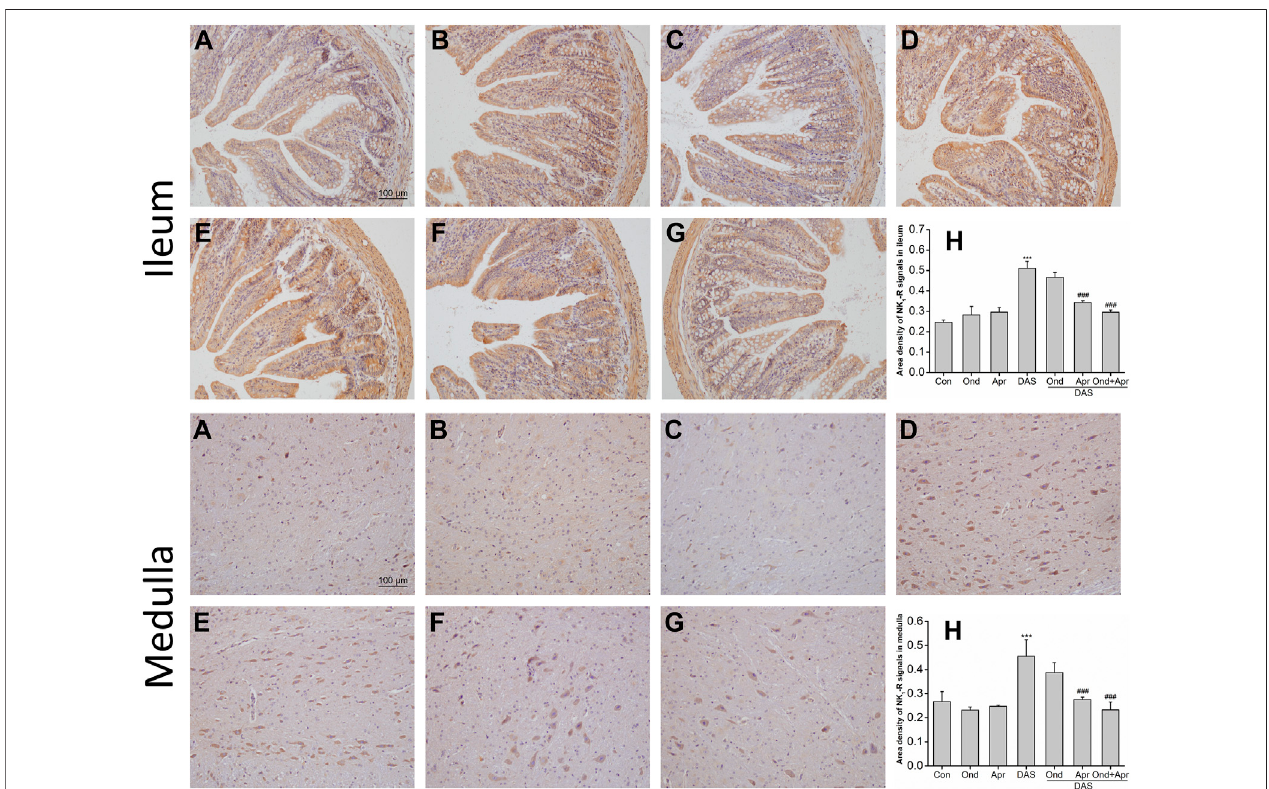
FIGURE10| Theeffect ofOndand Apron DAS-inducedNK 1 receptor expression intheileum and medullaofrats, 4 h after treatment: IHC analysis (A) Control (B) Ond1.66 mg/kg (C) Apr26.2 mg/kg (D) DAS2 mg/kg (E) DAS2 mg/kg+ Ond1.66 mg/kg (F) DAS2 mg/kg+ Apr26.2 mg/kg (G) DAS2 mg/kg +Ond 1.66 mg/kg + Apr 26.2 mg/kg. Ond and Apr were administered 30 min before DAS. Semi-quantitative analysis of the ratio of NK 1 R positive staining to the total fi eld (H) . Data are expressedasmean ± SEM.Statisticalsigni fi cancewasassessedusingtheone-wayANOVA.* p < 0.05, ** p < 0.01, *** p < 0.001vs.thecontrolgroup,and # p < 0.05, # # p < 0.01, # # # p < 0.001 vs. the DAS